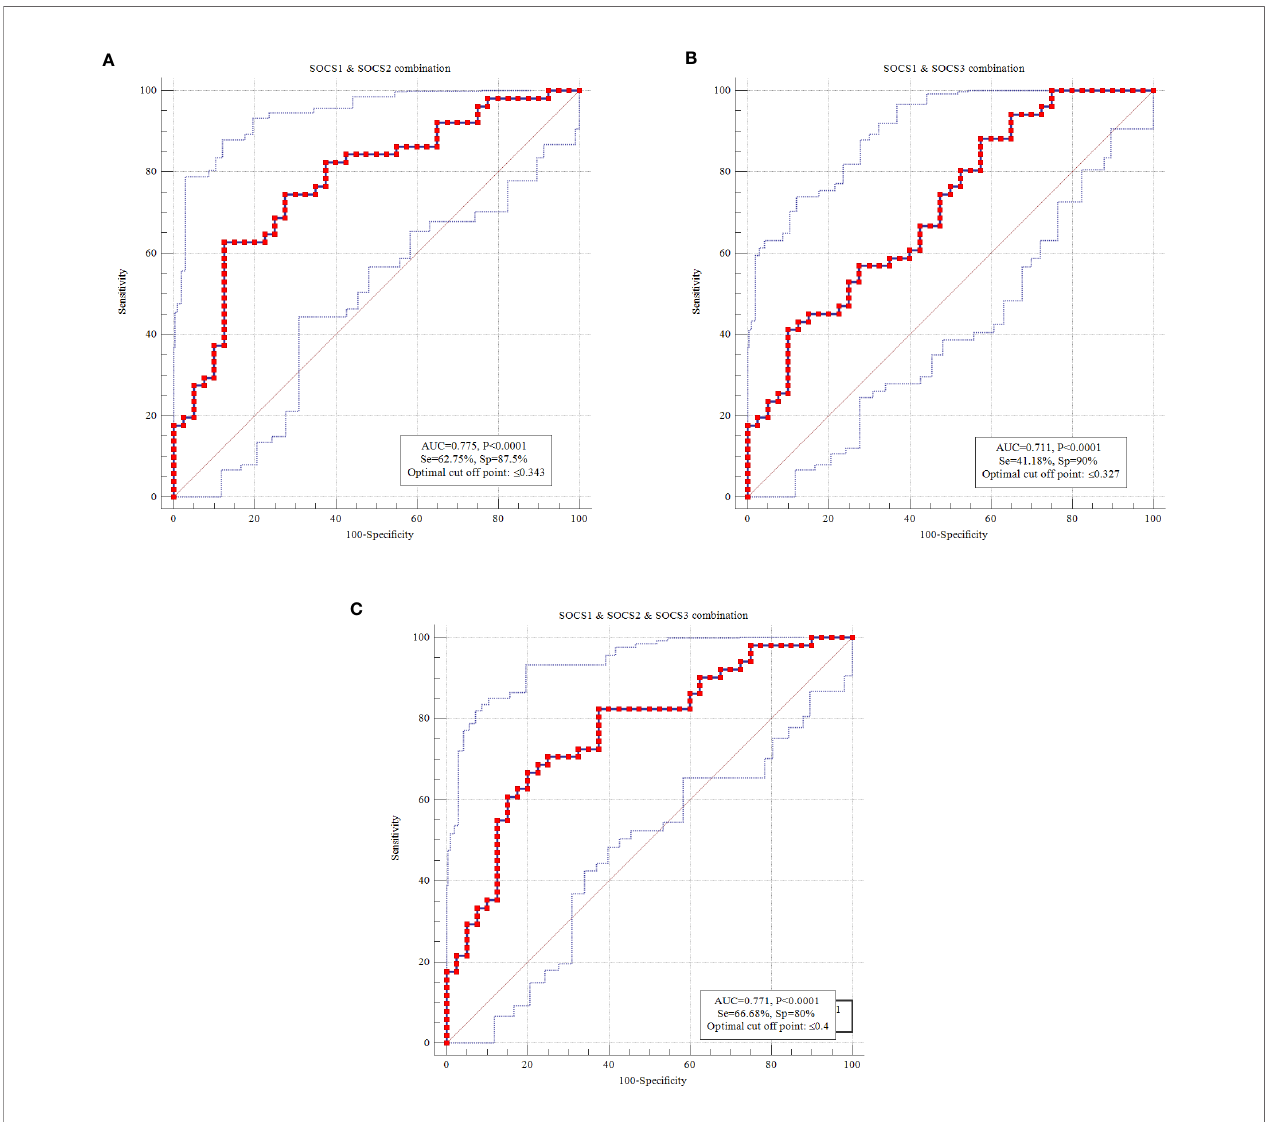
FIGURE 4 | ROC curves using combination of transcript amounts of SOCS1 and SOCS2 (A) , SOCS1 and SOCS3 (B) and SOCS1-3 (C)